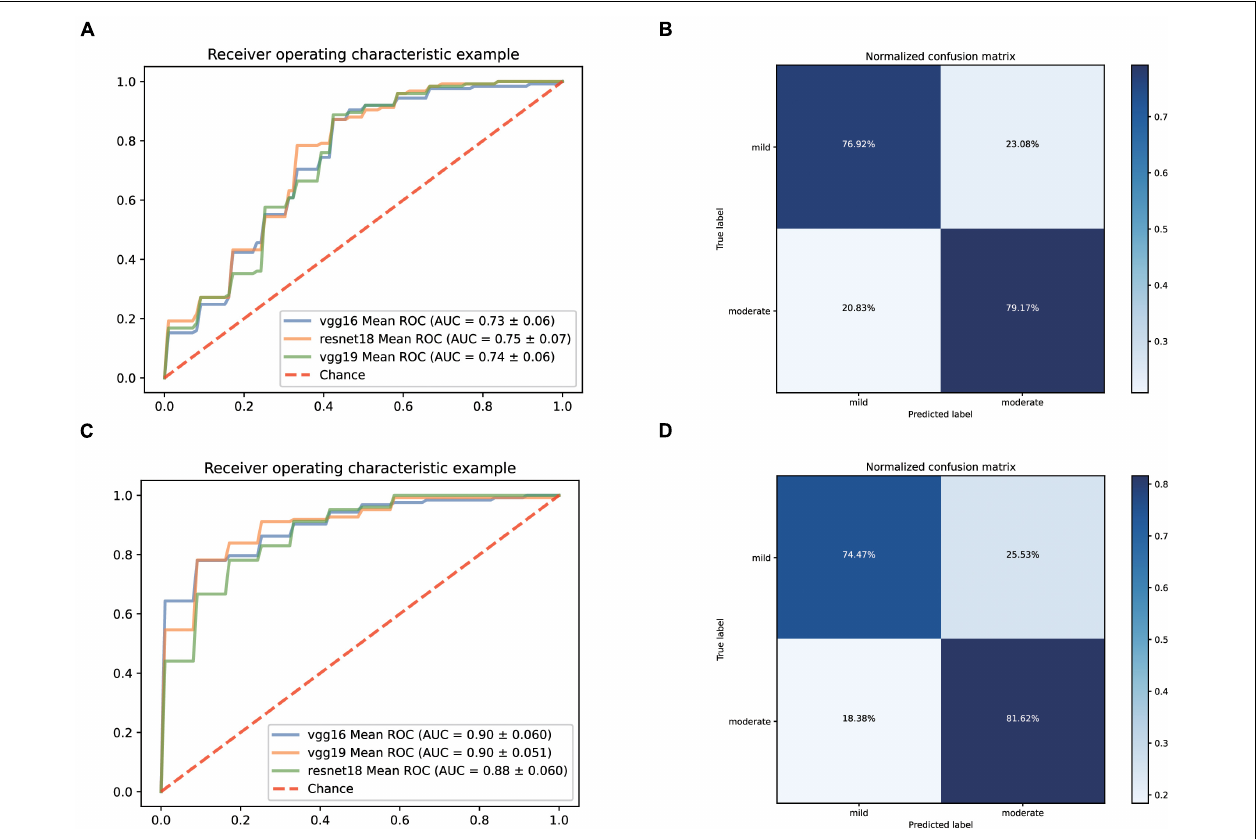
FIGURE 4 | Performance of our AI Systems in predicting mild and moderate types of COVID-19 based on the original CT images and on the original CT images plus biochemical indicators. (A,B) ROC curves and normalized confusion matrix of one model (resnet18) based on the original CT images. (C,D) ROC curves and normalized confusion matrix (vgg19) based on the original CT images and biochemical